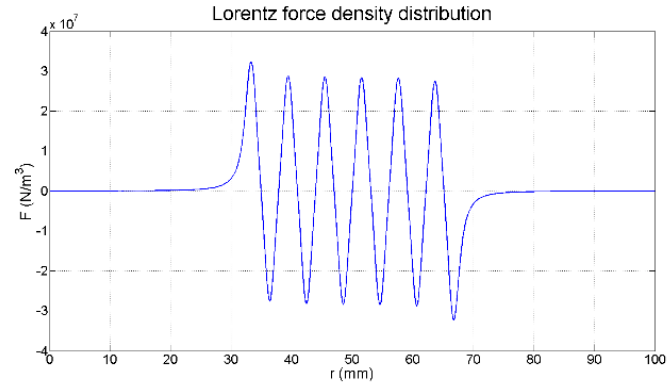
Figure 5. For a meander-line-coil, the distribution of the Lorentz force density F at z = 0. Reproduced with permission from [15], IEEE, 2016.